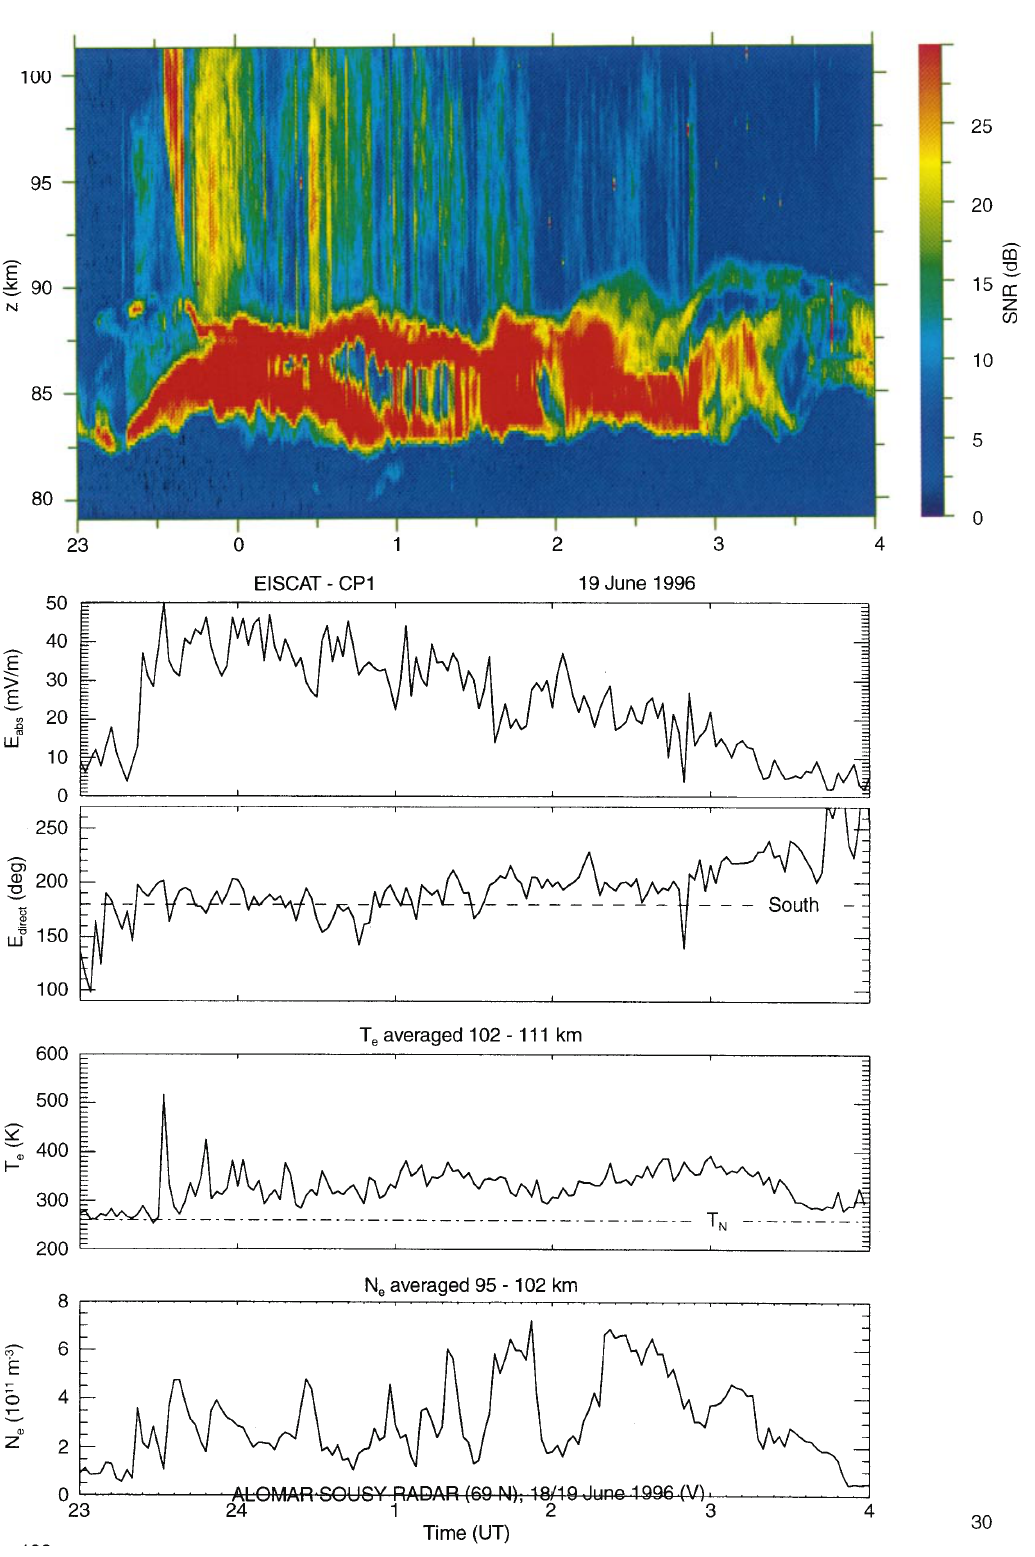
temperature ( fourth panel ) and electron density ( lowest panel ) averaged over 95 to 102 km. The last four quantities have been derived from